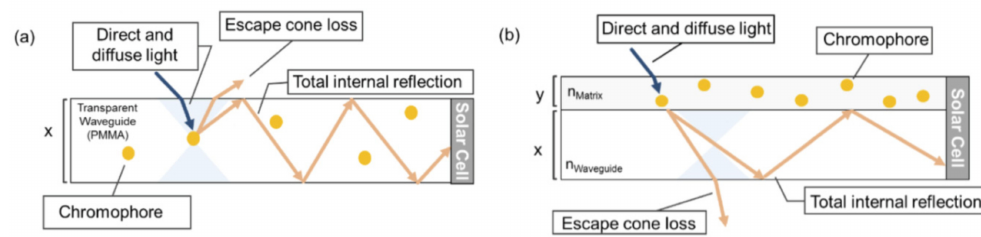
Figure 4. Conventional structures for luminescent solar concentrator (LSC) applications: ( a ) millimeter-thick waveguides infused with fluorescent dyes; ( b ) micron-thick thin layer matrices cast on top of a waveguide. (reprinted with permission from ref. [22], Copyright 2014 Nature Publishing